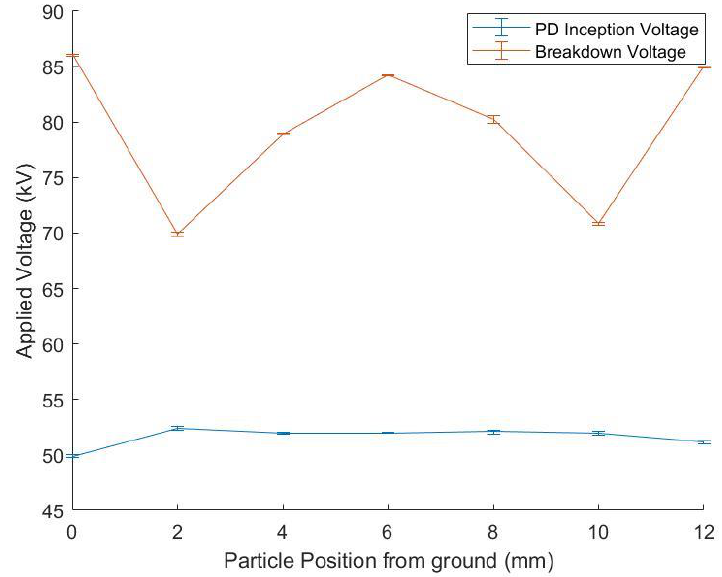
Figure 5. Characteristics of corona inception and breakdown voltages of 5 mm symmetrical particle.